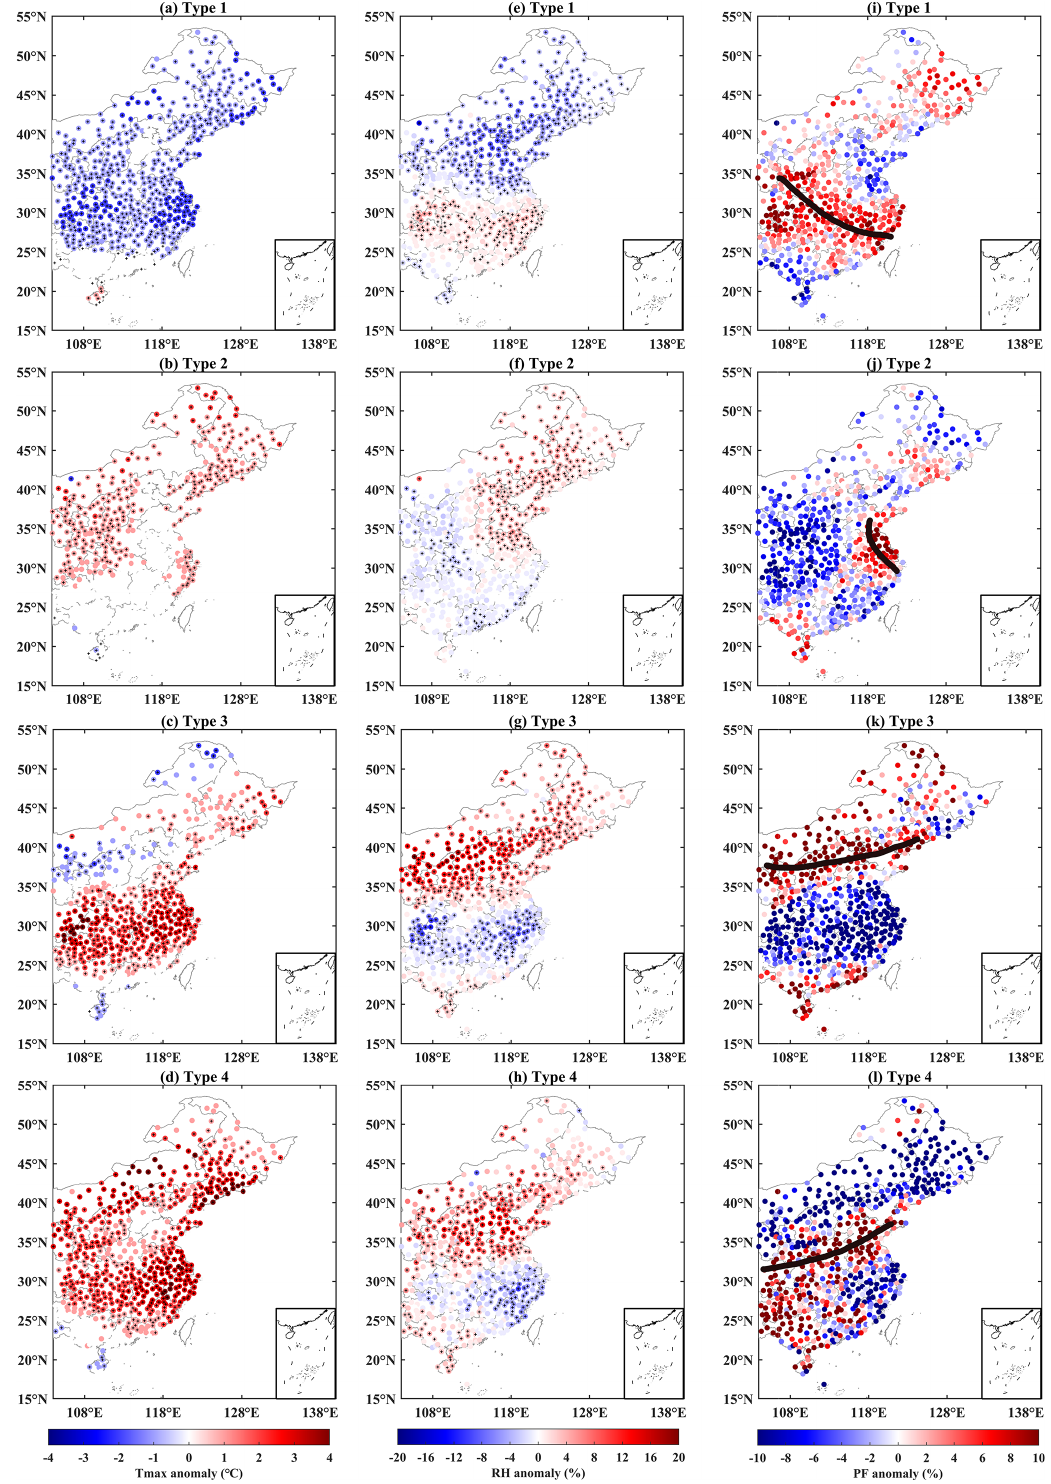
Figure 8. As in Fig. 6 but for T max (a–d) , RH (e–h) and PF (i–l) . The black solid line presents the rain belt of each SWP.